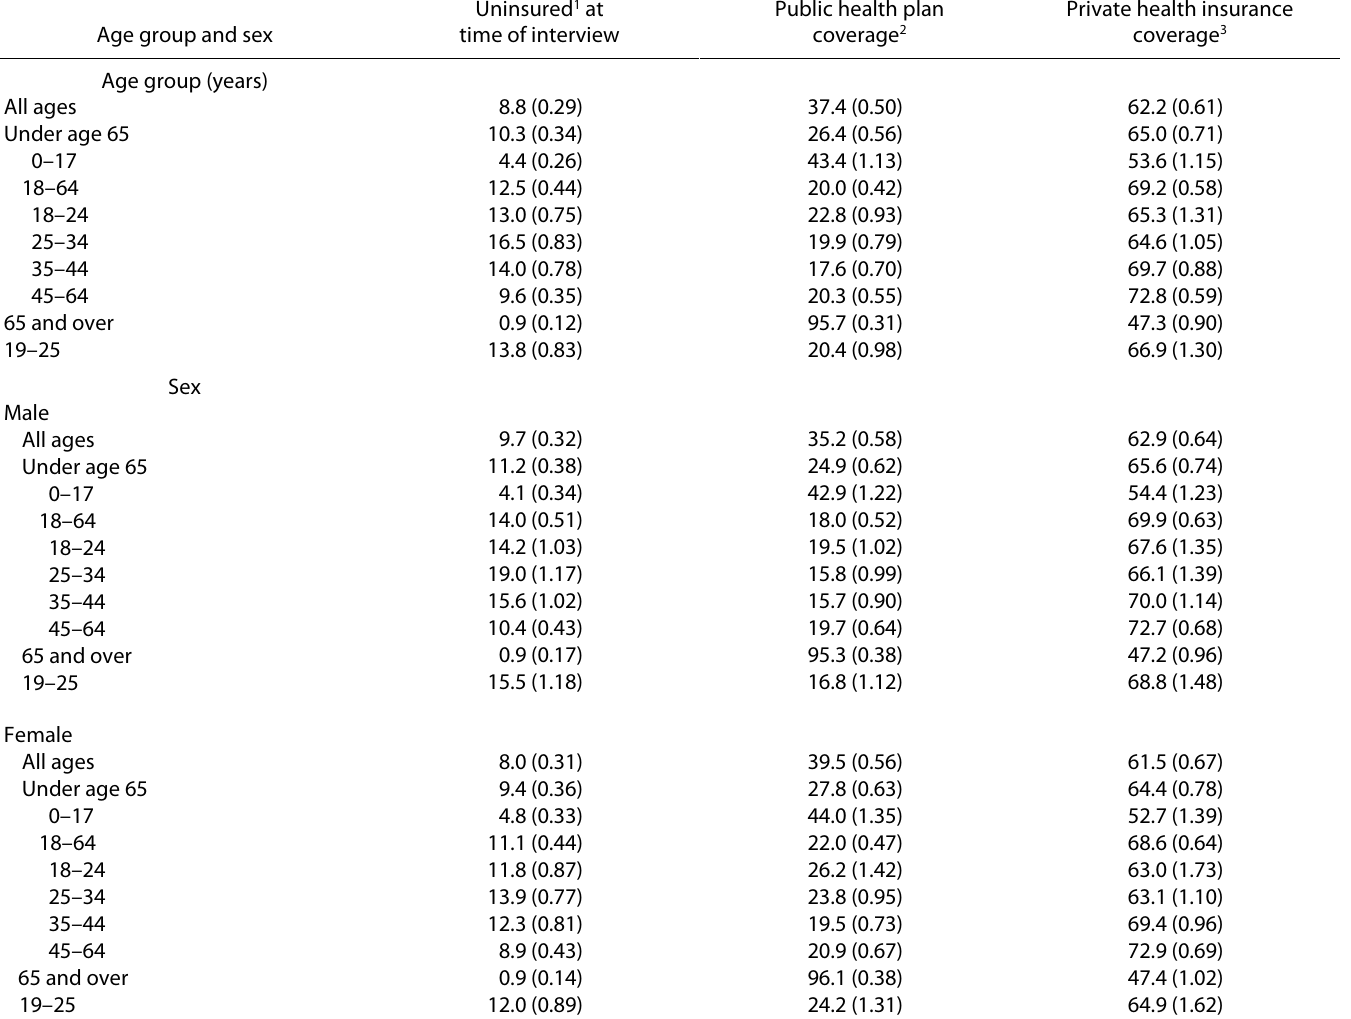
Table VII. Percentages (and standard errors) of persons who lacked health insurance coverage, had public health plan coverage, and had private health insurance coverage at the time of interview, by age group and sex: United States, January–June